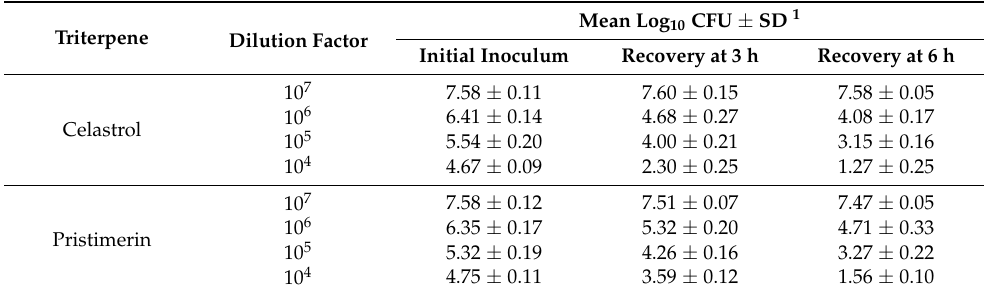
Figure 2. Time–kill curves of B. subtilis cultures expressed as Log 10 of CFU counts after treatment with different antimicrobial substances (celastrol 3 µg/mL; pristimerin 10 µg/mL; ciprofloxacin 1.2 µg/mL; rifampicin 0.15 µg/mL; tetracycline 7.5 µg/mL; and penicillin 9 µg/mL) added in lag phase of growth ( A ) and log phase after three hours of preincubation ( B ). Cultures without drugs and with the maximum proportion of DMSO were used as controls. Error bars express SD with n = 3. Table 2. Effect of celastrol at 3 µ g/mL and pristimerin at 10 µ g/mL on different inoculum sizes of B. subtilis at 3 and 6 h after